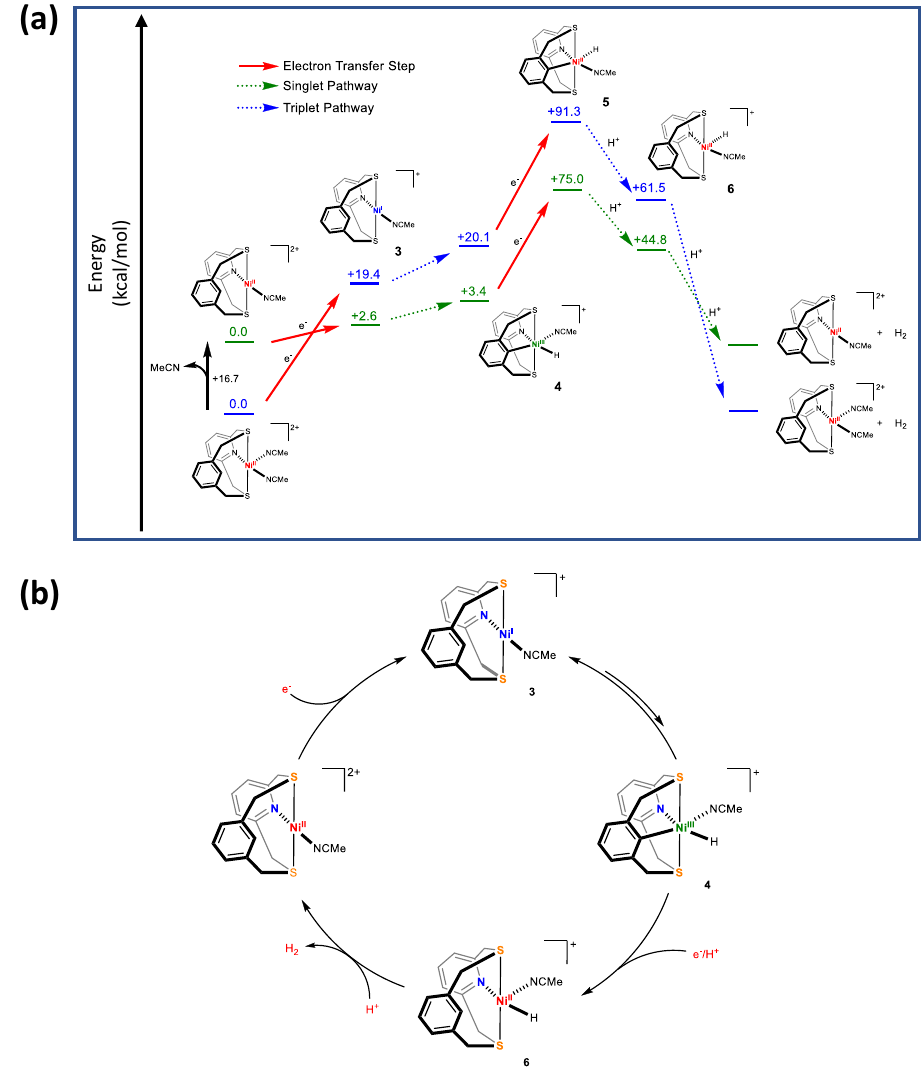
Fig. 7 | Mechanism of hydrogen evolution reaction catalyzed by 1. a Energy landscape of electrochemical HER catalyzed by 1 . All structures were optimized at UB3LYP/tzvp level of theory. The free energies of electron transfer reactions were calculated vs. Fc/Fc + in MeCN. The free energies of proton transfer reactions were calculatedbyusingCF 3 COOHandCF 3 COO − in MeCN.The energylevelscolored in